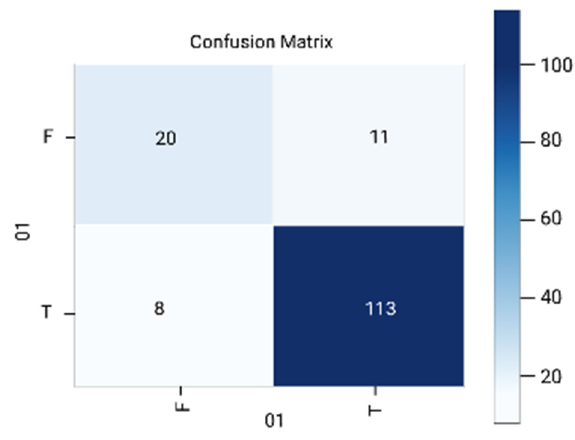
Figure 4. Proposed model with autoencoder ROC curve.